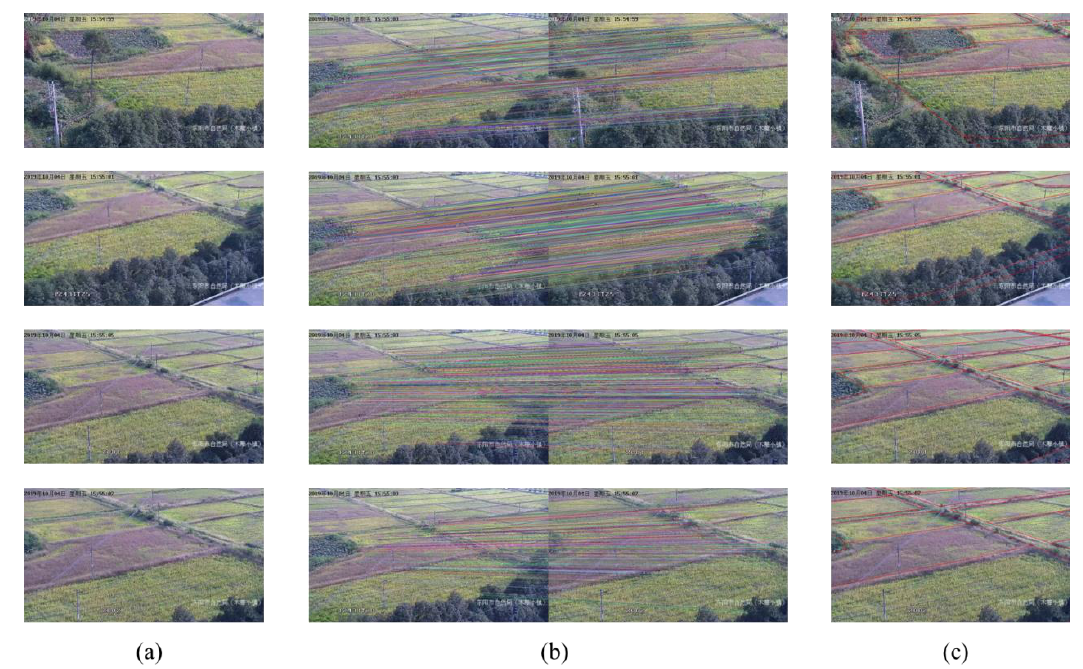
Figure 10. 2D BFPZs projected into different image space by using the proposed method in the MDXZ dataset. ( a ) Part frames of video. ( b ) The matching results, in which corresponding points are connected with a straight line. ( c ) Video frames overlaid with the projected BFPZs.